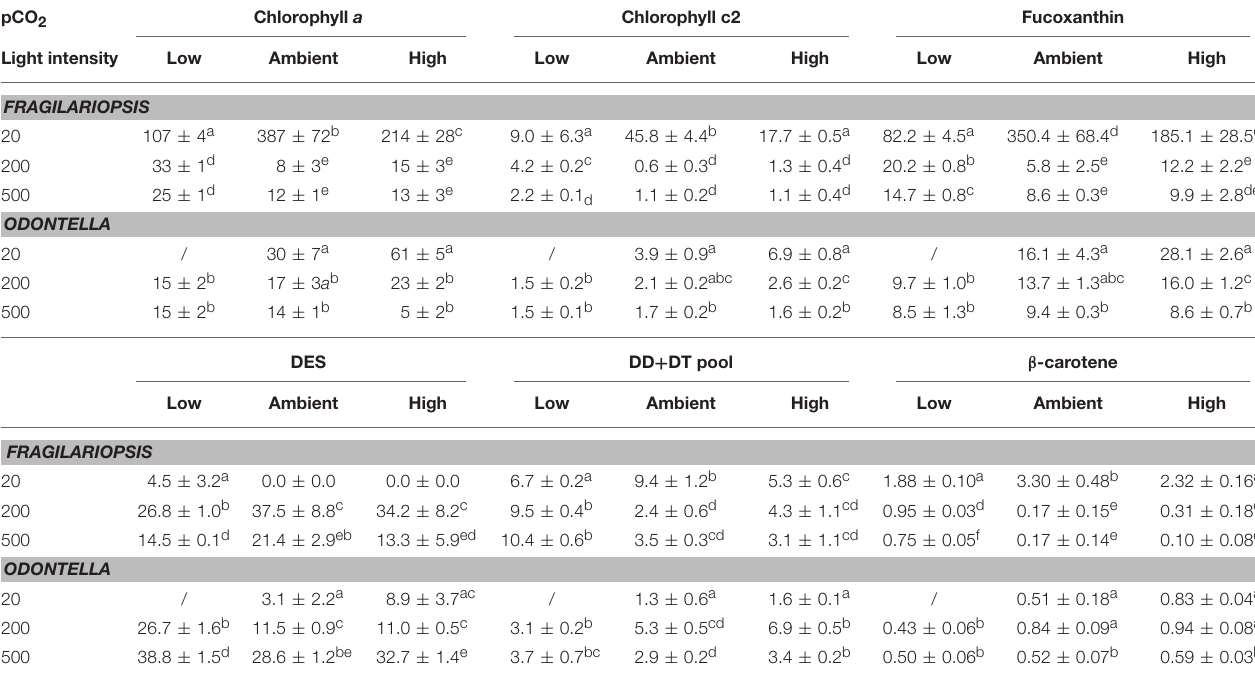
TABLE 3 | Cellular chlorophyll a (Chl a ), chlorophyll c2 (Chl c2), fucoxanthin, β -carotene, diadinoxanthin (DD) and diatoxanthin (DT) were determined for Fragilariopsis (fg cell − 1 ) and Odontella (pg cell − 1 ) acclimated to different light (LL = 20, ML = 200, HL = 500 µ mol photons m − 2 s − 1 ) and pCO 2 (low